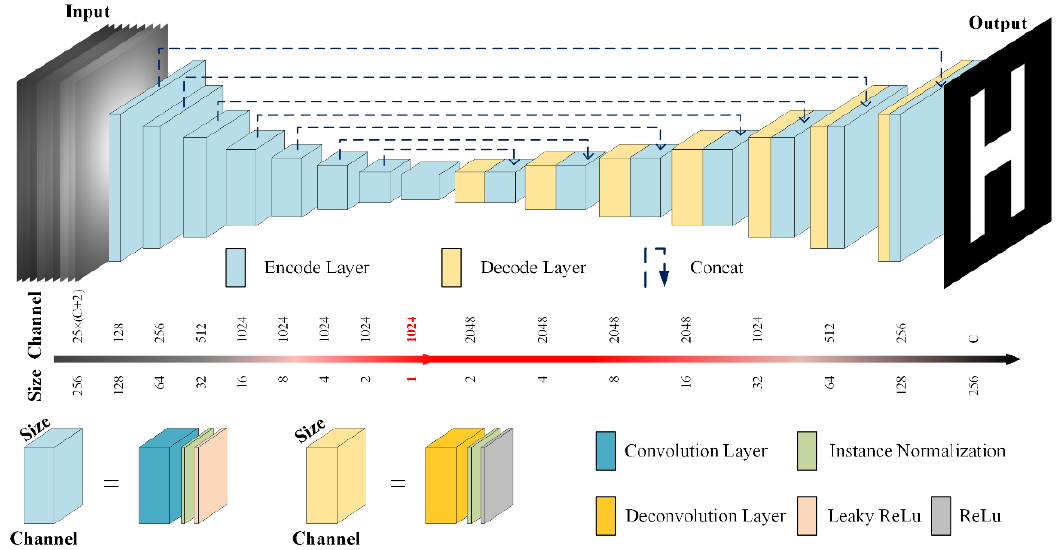
Figure 2. Detailed architecture of the reconstruction model.